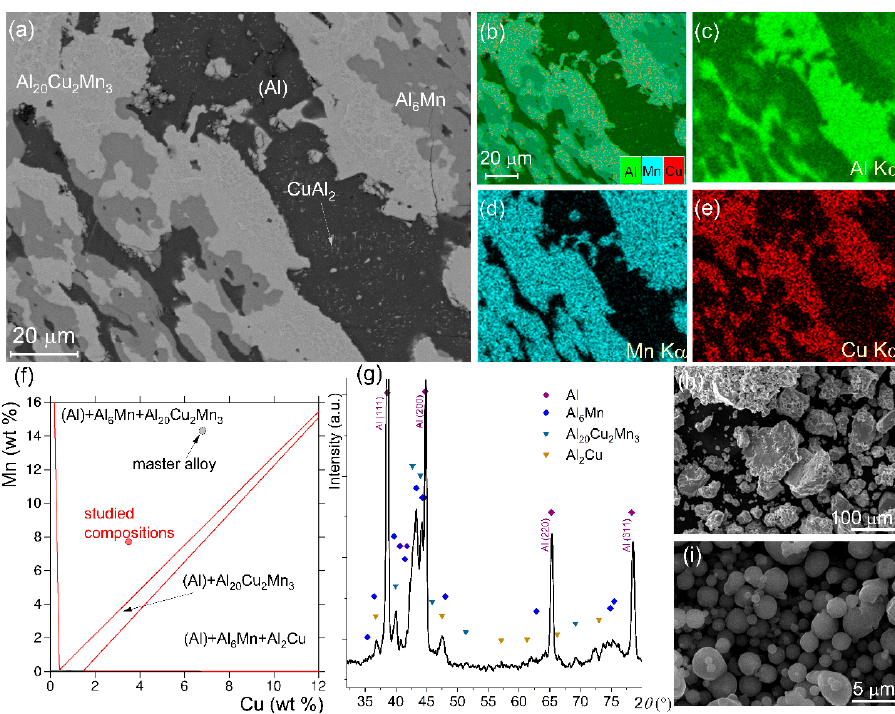
Figure 1. ( a ) SEM microstructure after solidification and further annealing at 520 °C for 24 h, ( b – e ) element distribution SEM-EDS maps, ( f ) isothermal cross section at 400 °C for the Al-Mn-Cu diagram, ( g ) XRD spectrum, ( h ) granules of the Al—14.3 wt% Mn—6.5 wt% Cu master alloy after mechanical milling for 20 h, and ( i ) SEM micrograph for Al powder.